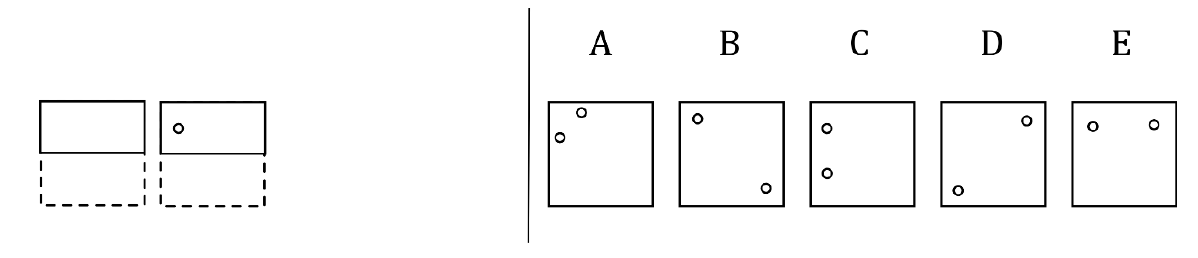
Figure 5. Example of paper folding item. Note. A paperfolding example from Ekstrom et al. (1976). Letter Series